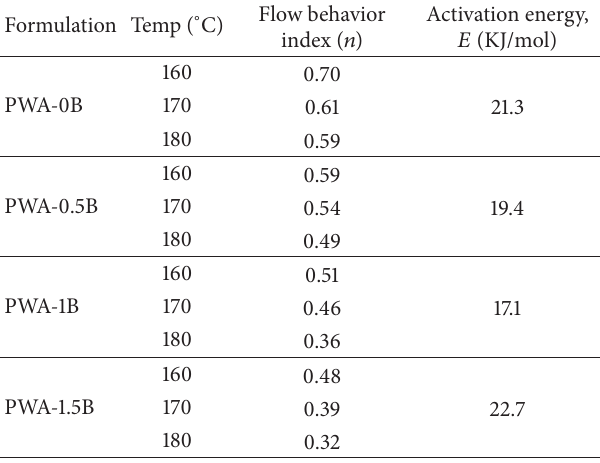
Table 3: Values of 𝑛 and 𝐸 for PWA-B feedstocks.